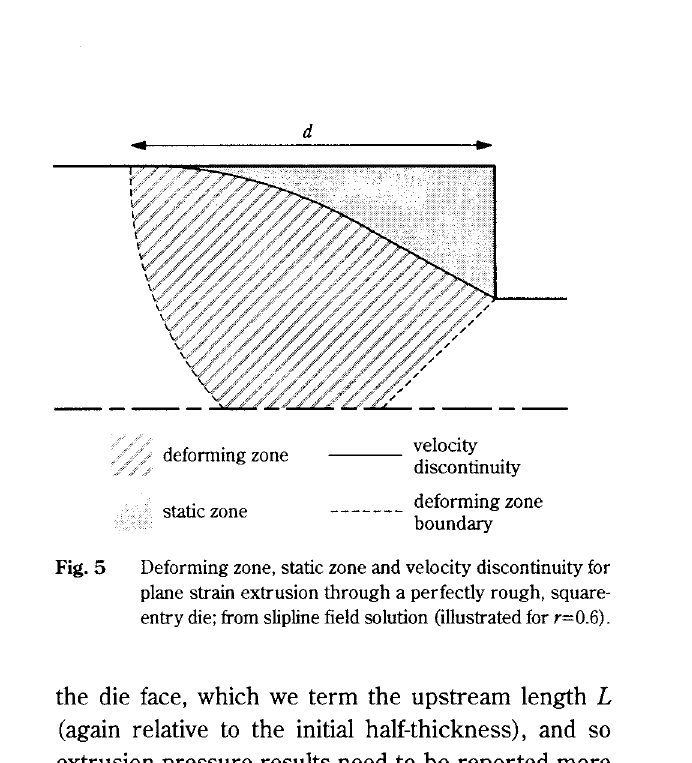
Fig. 5 Deforming zone, static zone and velocity discontinuity for plane strain extrusion through a perfectly rough, square entry die; from slipline field solution (illustrated for